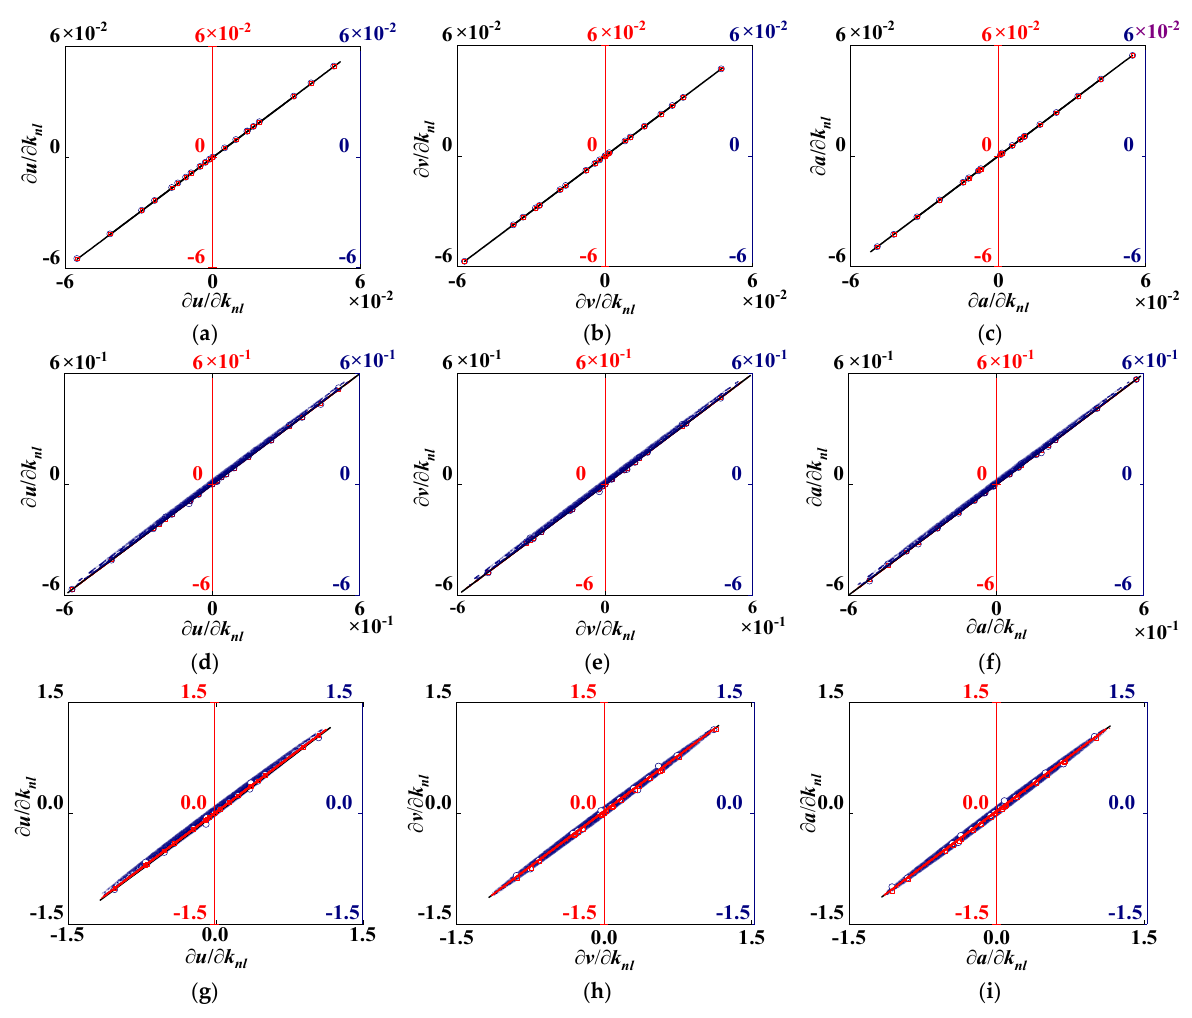
Figure 4. Comparison of response sensitivities ( a , d , g ) displacement, ( b , e , h ) velocity, and ( c , f , i ) ac- LPM vs. DDM (black color), LPM vs. FDM (red color), LPM vs. PCM (blue color). intervals: LPM vs. DDM (black color), LPM vs. FDM (red color), LPM vs. PCM (blue